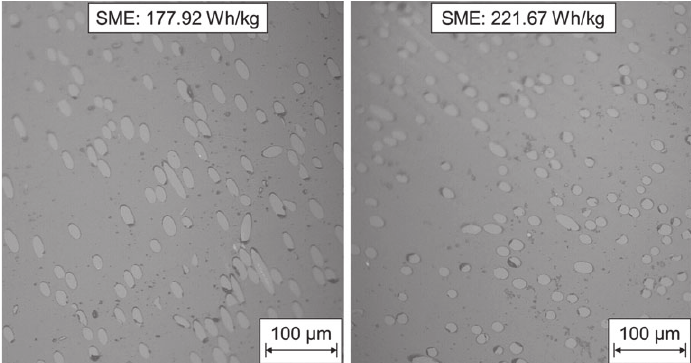
Figure 9 Dispersion of GF for two composites made with different SME using optical